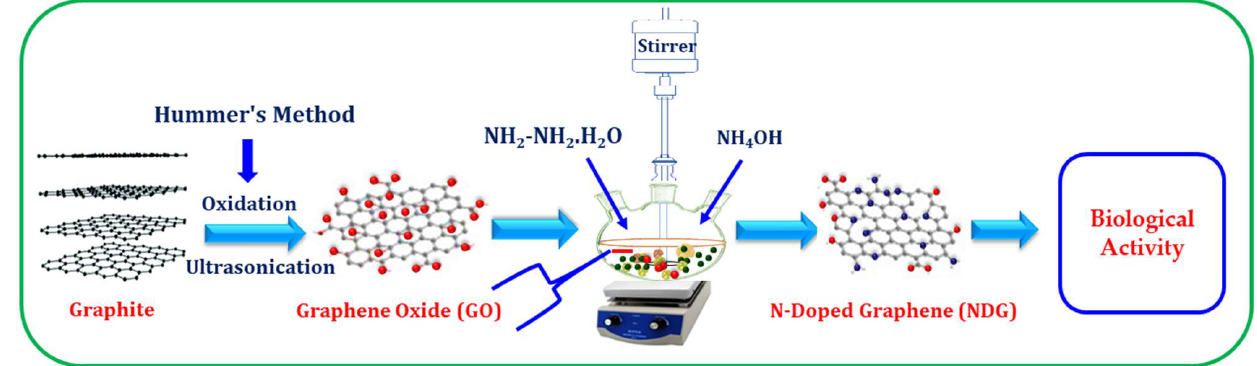
Scheme 1. Graphical representation of as-synthesized NDG, and the evaluation of their biofilm inhibition, antimicrobial, and anticancer activity.